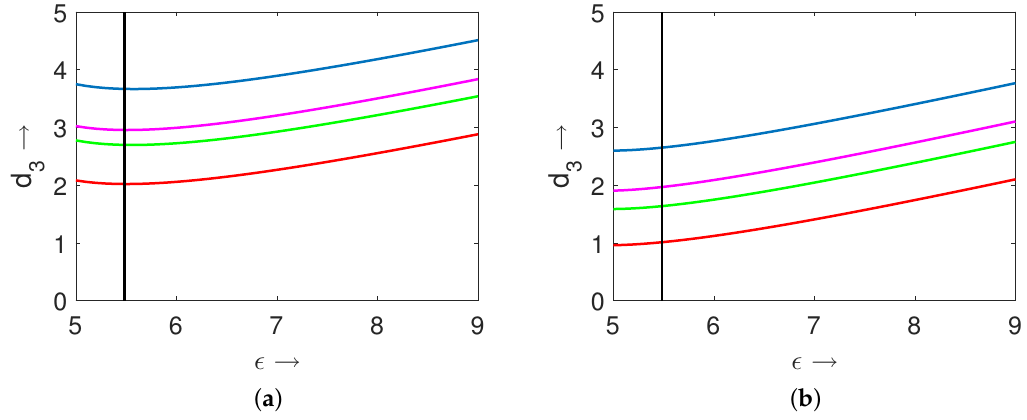
Figure 14. Plots of the temporal-Hopf and Turing bifurcation curves in ( (cid:101) , d 3 ) -parameter space for ( a ) d 2 = 0.2, and ( b ) d 2 = 0.1. Here, black vertical straight line corresponds to the temporal-Hopf threshold, blue curve represents the Turing curve for δ 1 = δ 2 = 0, magenta curve represents the Turing curve for δ 1 = 1.0 and δ 2 = 0, green curve represents the Turing curve for δ 1 = 0 and δ 2 = 1.0, and red curve represents the Turing curve for δ 1 = δ 2 = 1.0. The black vertical straight line has been drawn by solving the equations presented in (9) simultaneously and the red curve has been drawn from the Equation (39). The magenta and green curves have been drawn from Equations (A4) and (A5), respectively. Brief derivations of Equations (A4) and (A5) are provided in Appendix